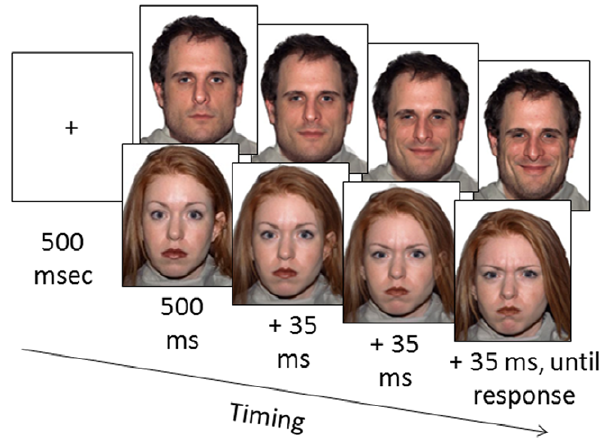
Figure 1. Two possible morph sequences, timed to give the impression of a video clip in real time (endpoint images adapted from Tottenham, et al., 2009; the people displayed provided consent for publication of the photos in publications and on the web).